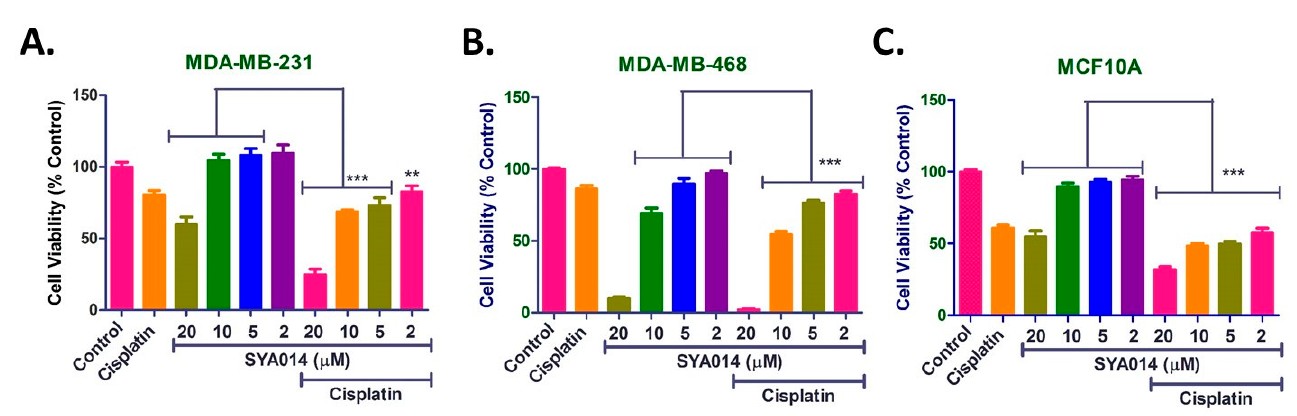
Figure 11. Cytotoxic effects of combination treatment with SYA014 and cisplatin for 72 h in MDA-MB-231 ( A ), MDA-MB-468 ( B ) and MCF10A cells ( C ). The cell viabilities were determined using resazurin reduction assay as described in the materials and methods section. Each experiment was performed in triplicate and the data points represent the mean ± SEM of 6–8 wells for each experiment. The results were plotted using GraphPad Prism version 5.0. ** p < 0.01 and *** p < 0.001.